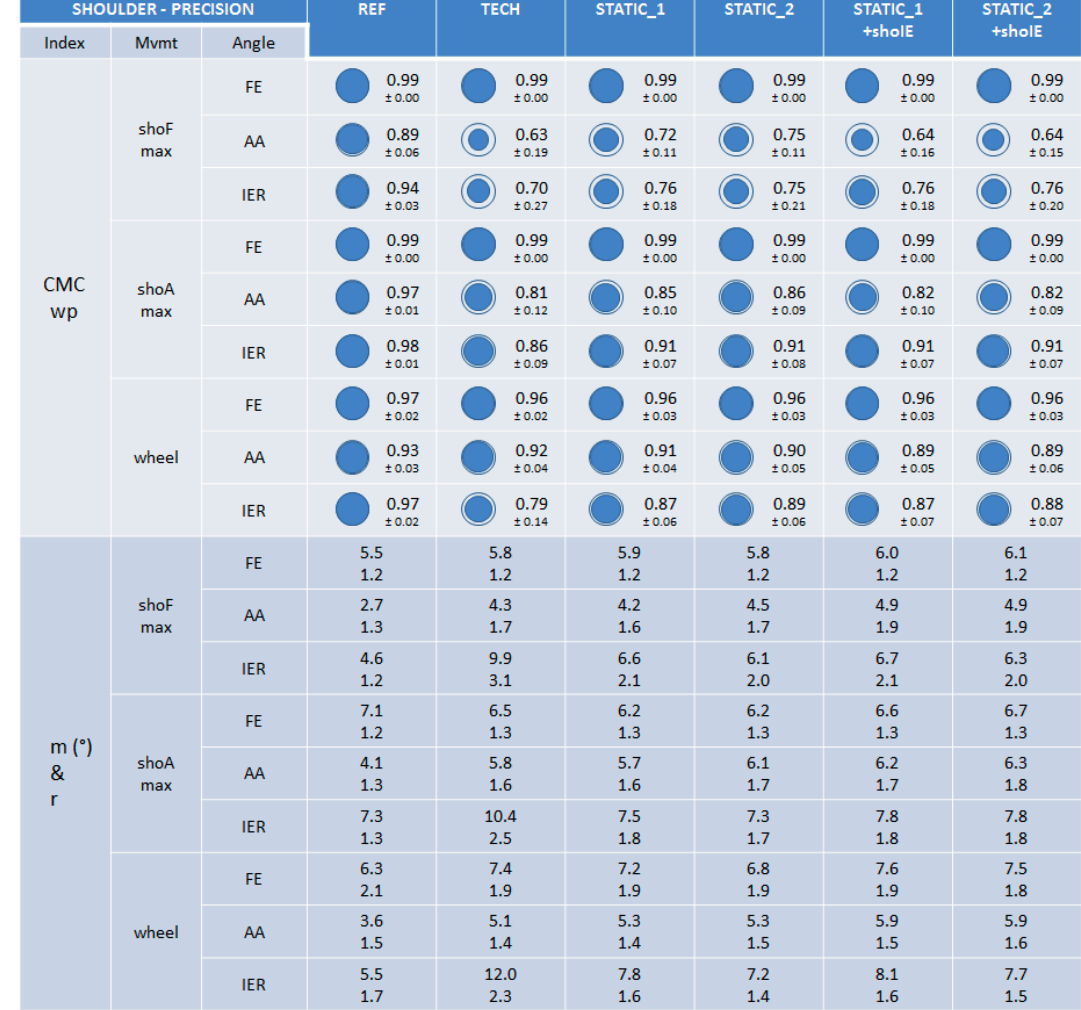
Figure 10. The results on precision for the shoulder joint. CMCwp, m , and r values are reported for the different calibrations and for the REF method during maximal shoulder flexion (shoFmax), maximal shoulder abduction in the scapular plane (shoAmax), and wheel movements. For visual clarity, the CMCwp value is completed with a proportional blue disc included in a blue circle that represents the optimal value